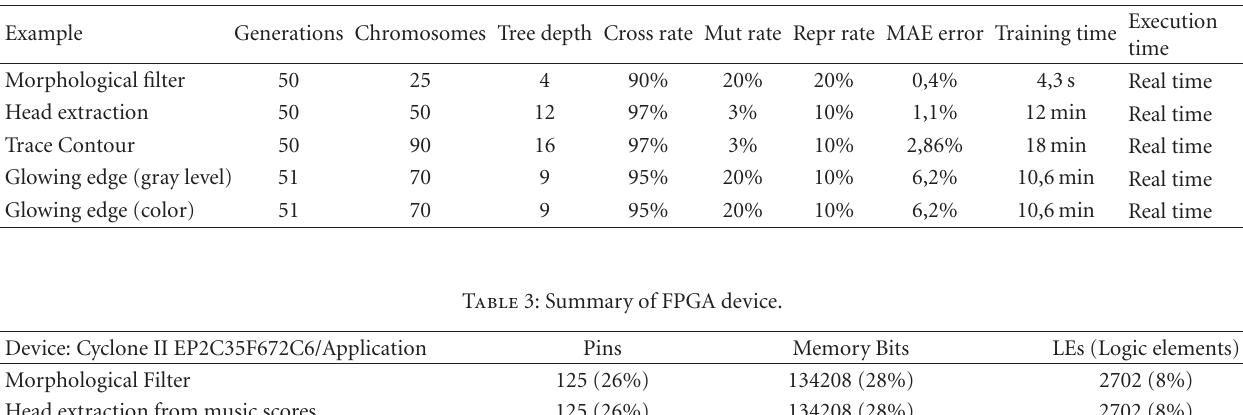
Table 2: Summary of results.